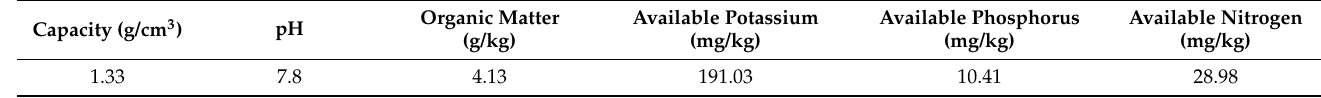
Table 3. Physicochemical properties of the reclaimed soil sample.